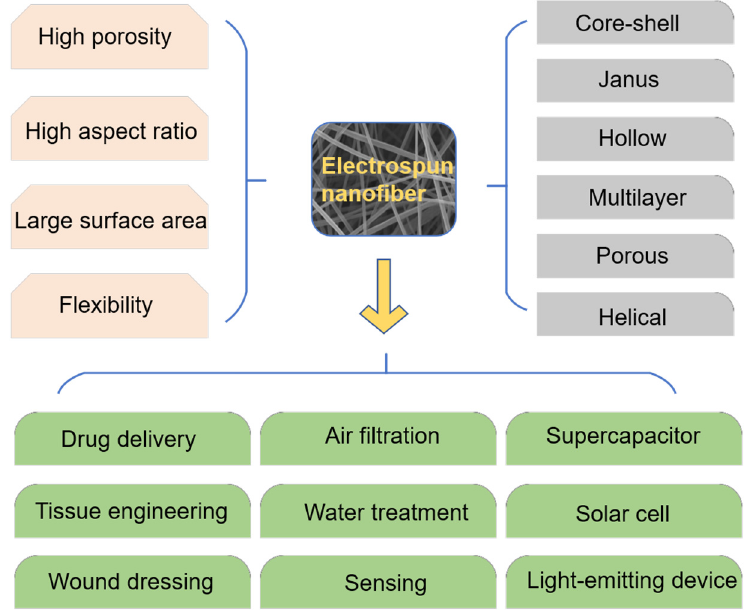
Figure 9. Structure, performance and application of electrospun nanofiber.